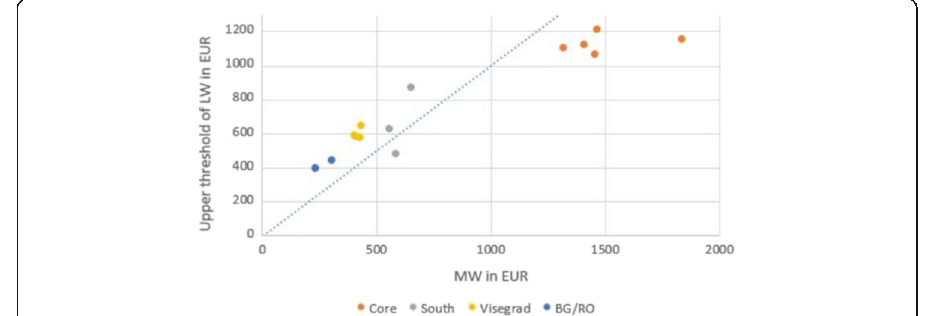
Fig. 2 Graphical distribution of countries based on individual MW and LW. Source: own calculation based on WI from December 2016. Q1 2017 Eurostat data used for MWs